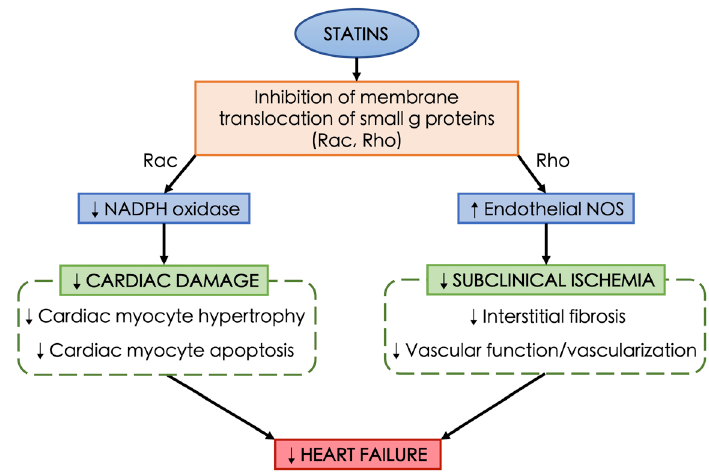
Figure 1. Proposed mechanism of pleiotropic effects of statins and heart failure prevention. Statins causes inhibition of membrane translocation of small g proteins, such as Rac and Rho. Inhibition of Rac pathway leads to the reduction of NADPH oxidase which results in less cardiac damage including cardiac myocyte hypertrophy and apoptosis. Similarly, inhibition of Rho pathway causes increased endothelial nitric oxide synthase (NOS) production leading to lower subclinical ischemia by reducing interstitial fibrosis, vascular function, and vascularization. Both mechanisms are proposed to prevent heart failure.